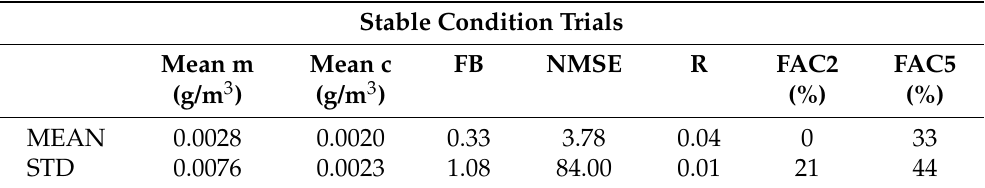
Table 5. Statistical analysis for the mean concentration and the concentration standard deviation in the stable cases. m indicates measured and c